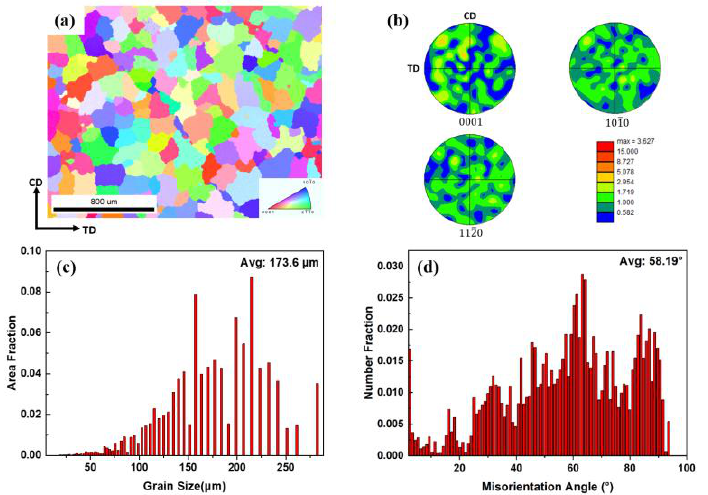
Figure 7. ( a ) The inverse pole figure (IPF) map, ( b ) pole figure, ( c ) grain size, and ( d ) misorientation angle distribution of as-homogenized ZK60 Mg alloy.